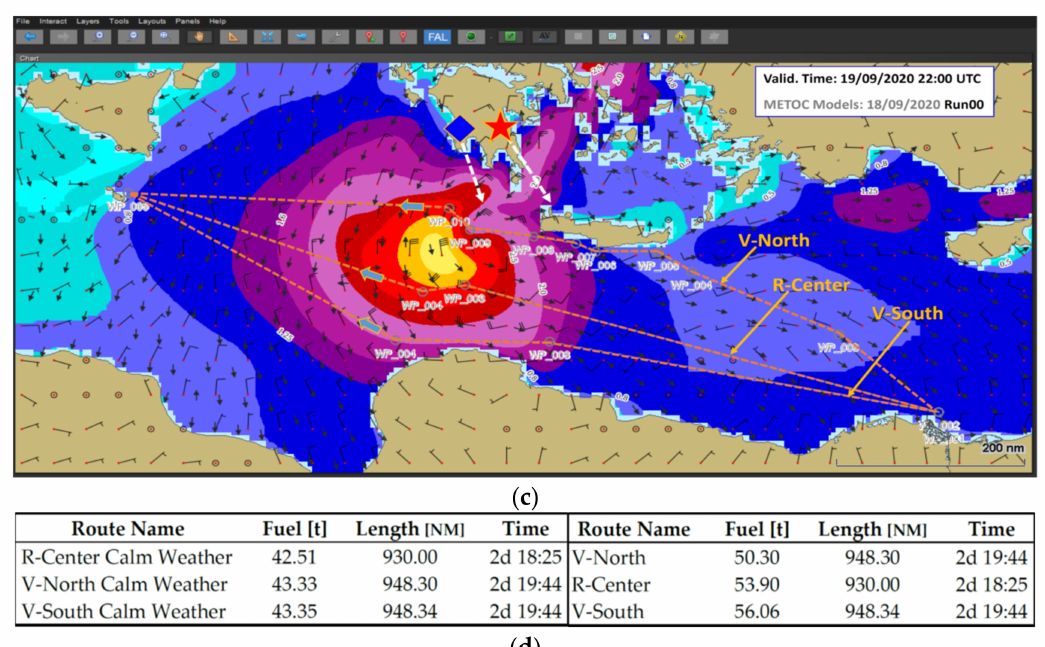
Figure 11. Panels ( a) –( c ) prototype interface showing: SWH, Average Wave Direction, and Wind Barbs maps for three times during the simulated Port Said-La Valletta voyage. Three alternative routes are shown. Blue arrows indicate ship positions at the maps’ validity times. Panel ( d ) fuel estimates: left in calm weather, right with metocean data. The Time columns show voyage duration in days, hours, and minutes (<days>d